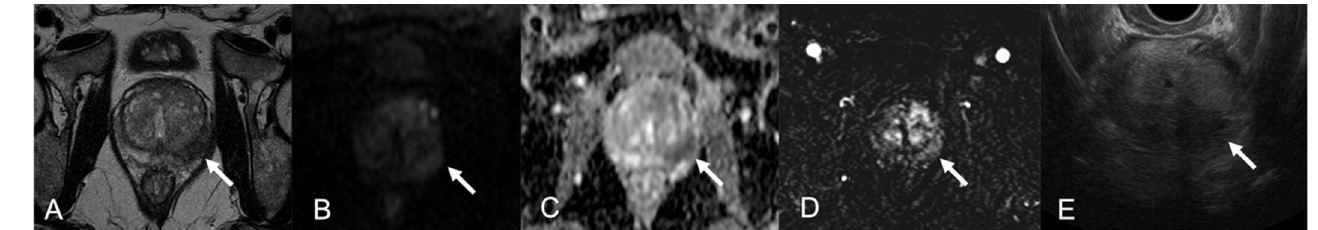
Figure 4. Non-specific GP in a 67-year-old patient (case 5). mpMRI showed a 2.8-cm hypointense lesion of the left prostate base (arrow in ( A )), hyperintense in DWI (arrow in ( B )) with markedly low ADC value (arrow in ( C )) and an early and prolonged enhancement with high peak (arrow in ( D )). At the transrectal US performed prior to the biopsy, we can see a wide hypoechoic peripheral area, which corresponds to the mpMRI findings (arrow in ( E )). PIRADS v2.1 5 PZpl mid-left.